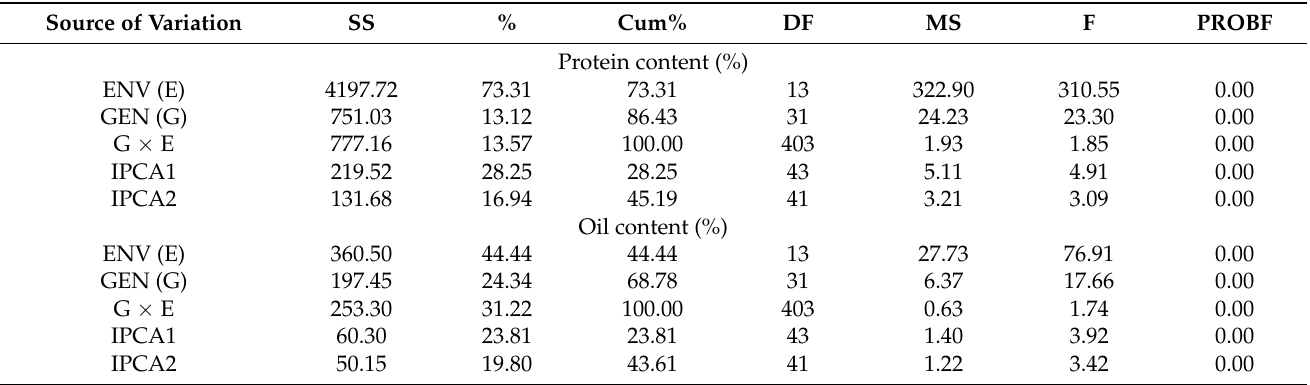
Table 3. AMMI analysis of variance for protein and oil content of 32 soybean genotypes over 14 environments including the first two interaction principal component axes